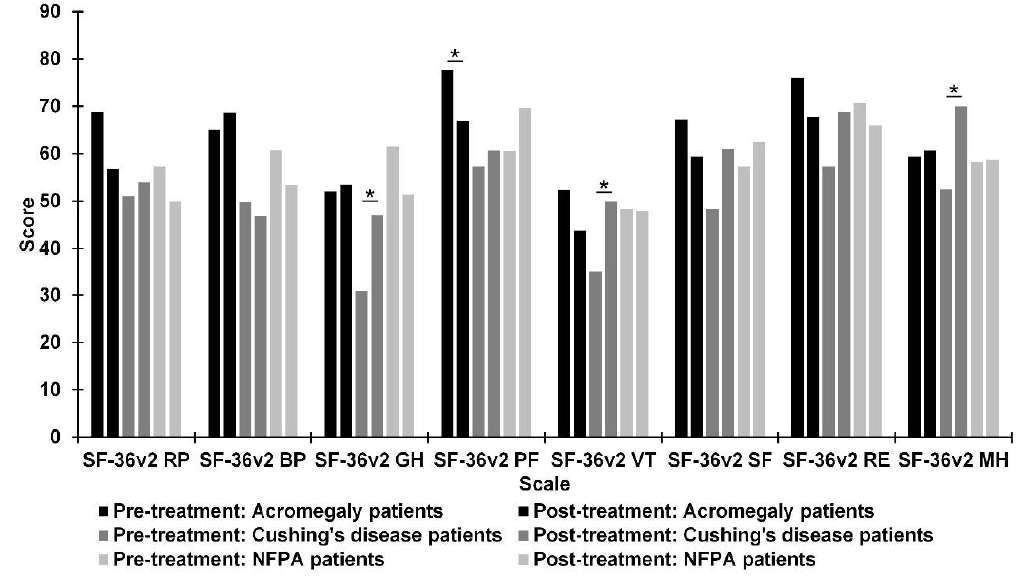
Figure 4. Differences between pre- and post-treatment in patients with acromegaly, patients with Cushing’s disease, and non-functioning pituitary adenoma (NFPA) patients on Short Form Health Survey version 2 (SF-36v2) scores between pre- and post-treatment. SF-36v2: BP = Bodily Pain; GH = General Health; MH = Mental Health; PF = Physical Functioning; RE = Role Emotional; RP = Role Physical; SF = Social Functioning; VT = Vitality. * p <